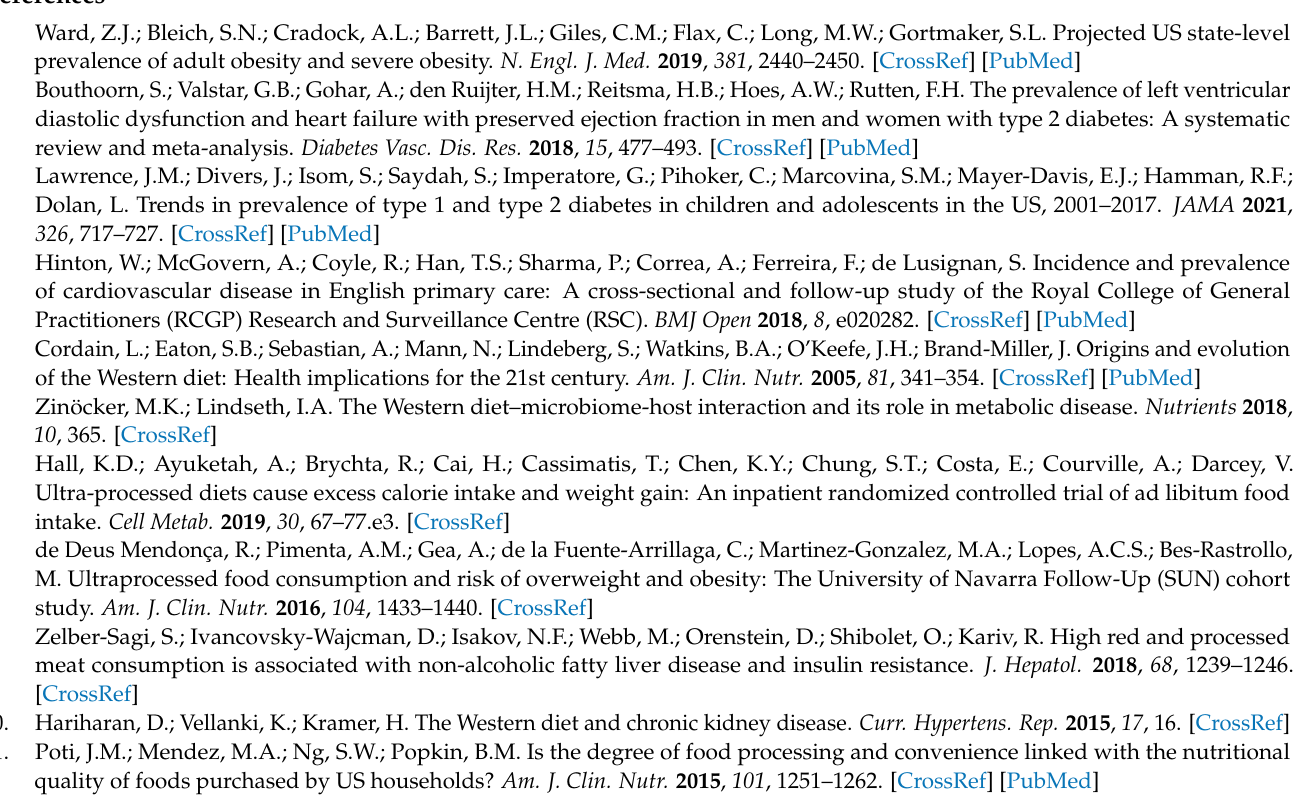
Table S2B: The effects of dietary fat, protein source and pH enhancement in weekly body weight in female mice; Table S3A: Male glucose tolerance test results (Time point 0 to 120 min); Table S3B: Female glucose tolerance test results (Time point 0 to 120